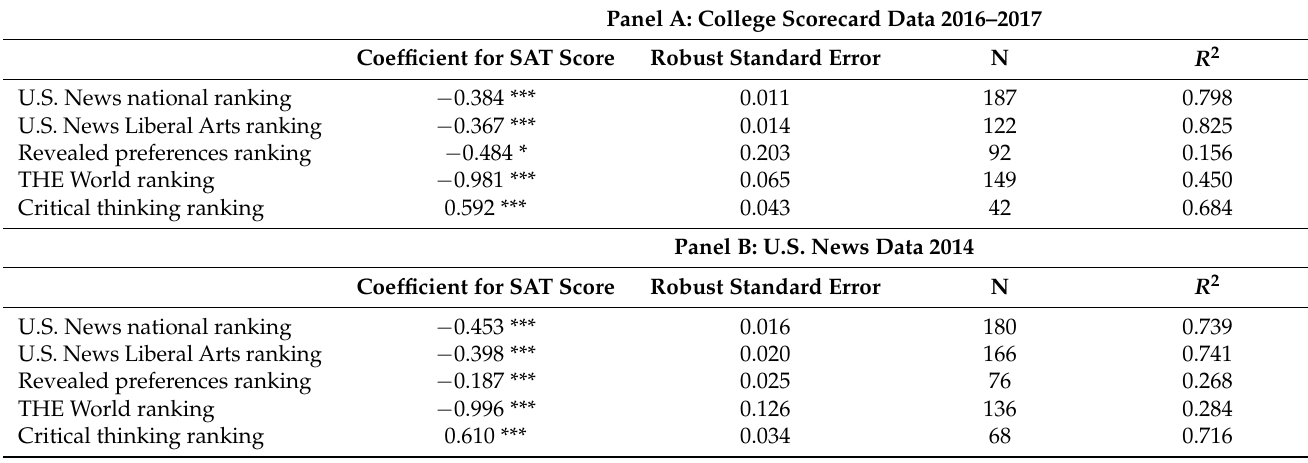
Table A3. SAT predicting college and university rankings using Model 1 with unrestricted samples. Panel A: College Scorecard Data